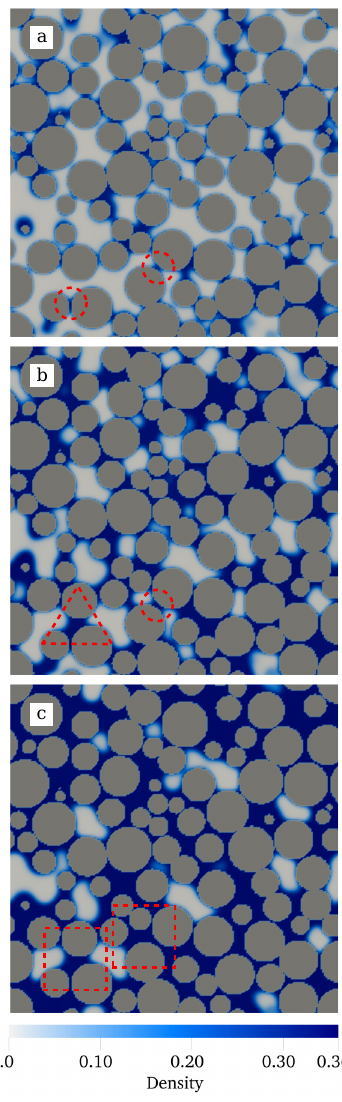
Figure 3. Snapshots of 2D slices of the multiphase domain with η = 0.40 at (a) S r = 0.1, (b) S r = 0.4 and (c) S r = 0.7. The dashed- circle zones show examples of binary liquid bridges, the dashed- triangle zone shows an example of a liquid cluster connecting multiple grains, and the dashed-square zones show examples of concave menisci in the capillary state.